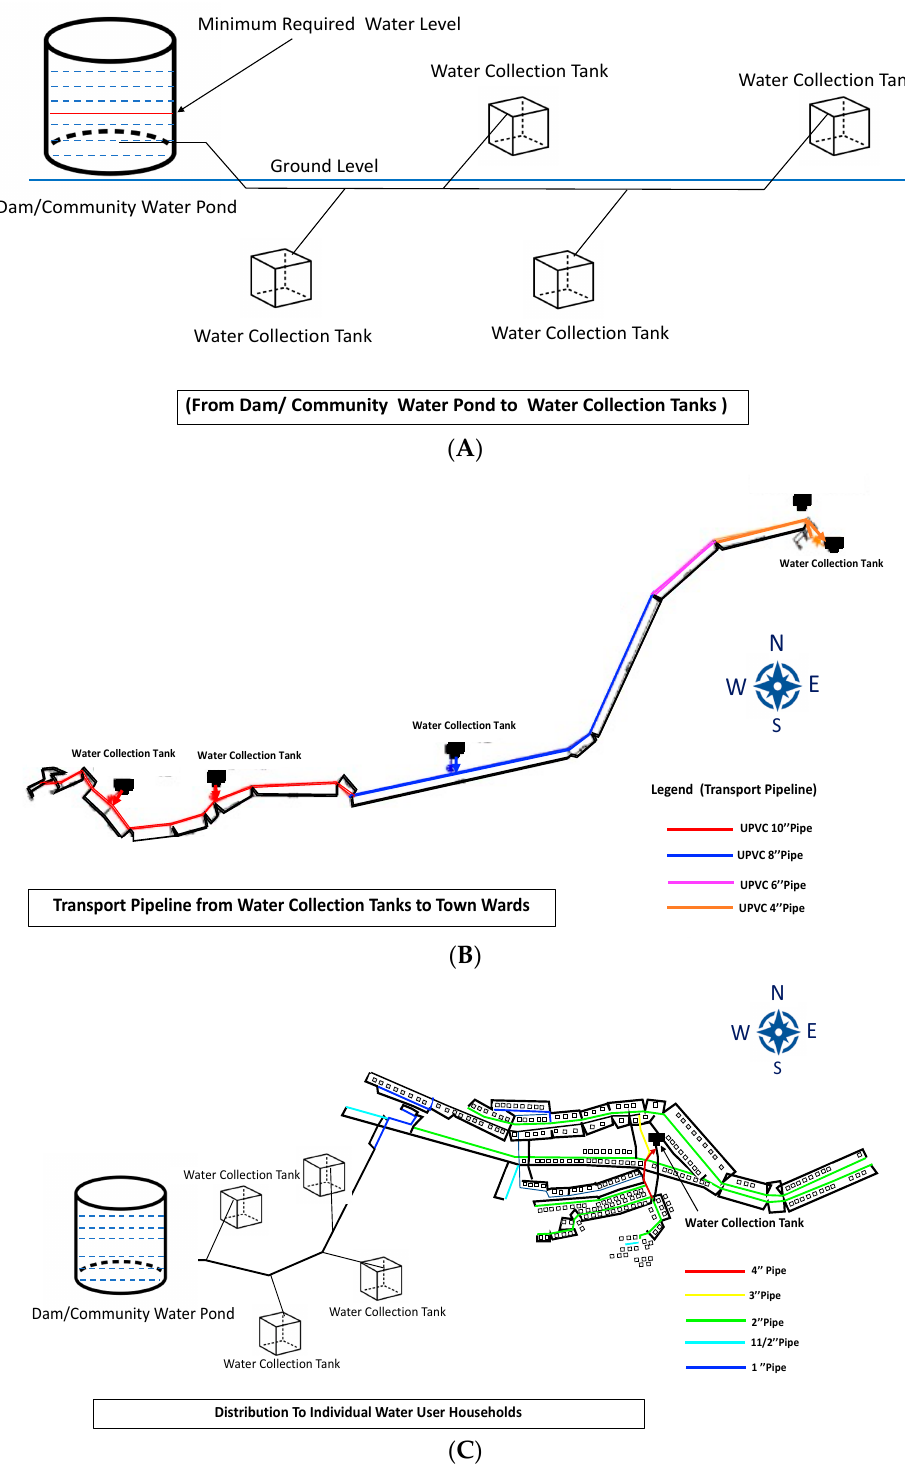
Figure 2. ( A ). Schematic diagram of public water supply system ( B ). Schematic diagram of public water supply system. ( C ). Schematic diagram of public water supply system in the study area. Source: Rakhine State Department of Municipal/Development Affairs, 2021.